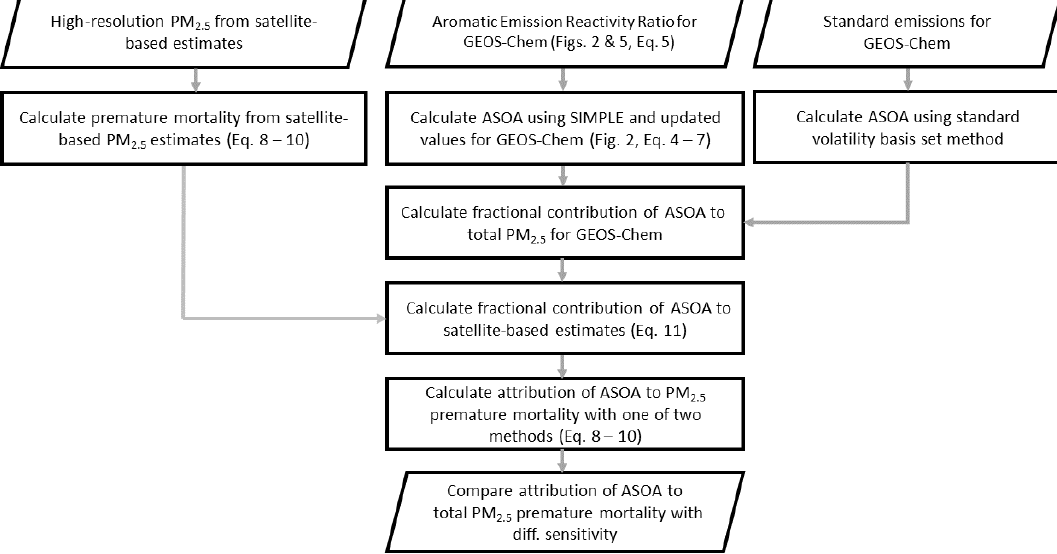
Figure 7. Flowchart describing how observed ASOA production was used to calculate ASOA in GEOS-Chem, and how the satellite-based PM 2 . 5 estimates and GEOS-Chem PM 2 . 5 speciation were used to estimate the premature mortality and the attribution of premature mortality by ASOA. See Sect. 2 and the Supplement for further information about the details in the figure. SIMPLE is described in Eq. (4) and by Hodzic and Jimenez (2011) and Hayes et al. (2015). The one of two methods mentioned include either the integrated exposure-response (IER) (Burnett et al., 2014) with Global Burden of Disease (GBD) dataset (IHME, 2016) or the new Global Exposure Mortality Model (GEMM) (Burnett et al., 2018) methods. For both IER and GEMM, the marginal method (Silva et al., 2016) or the attributable fraction method (Anenberg et al., 2019) are used.